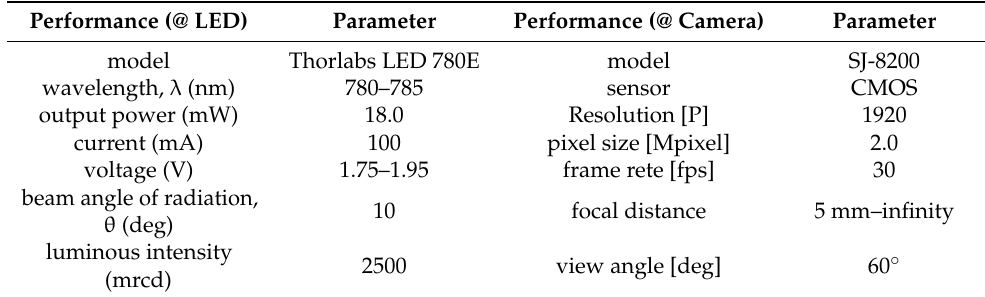
Table 2. Experimental device module